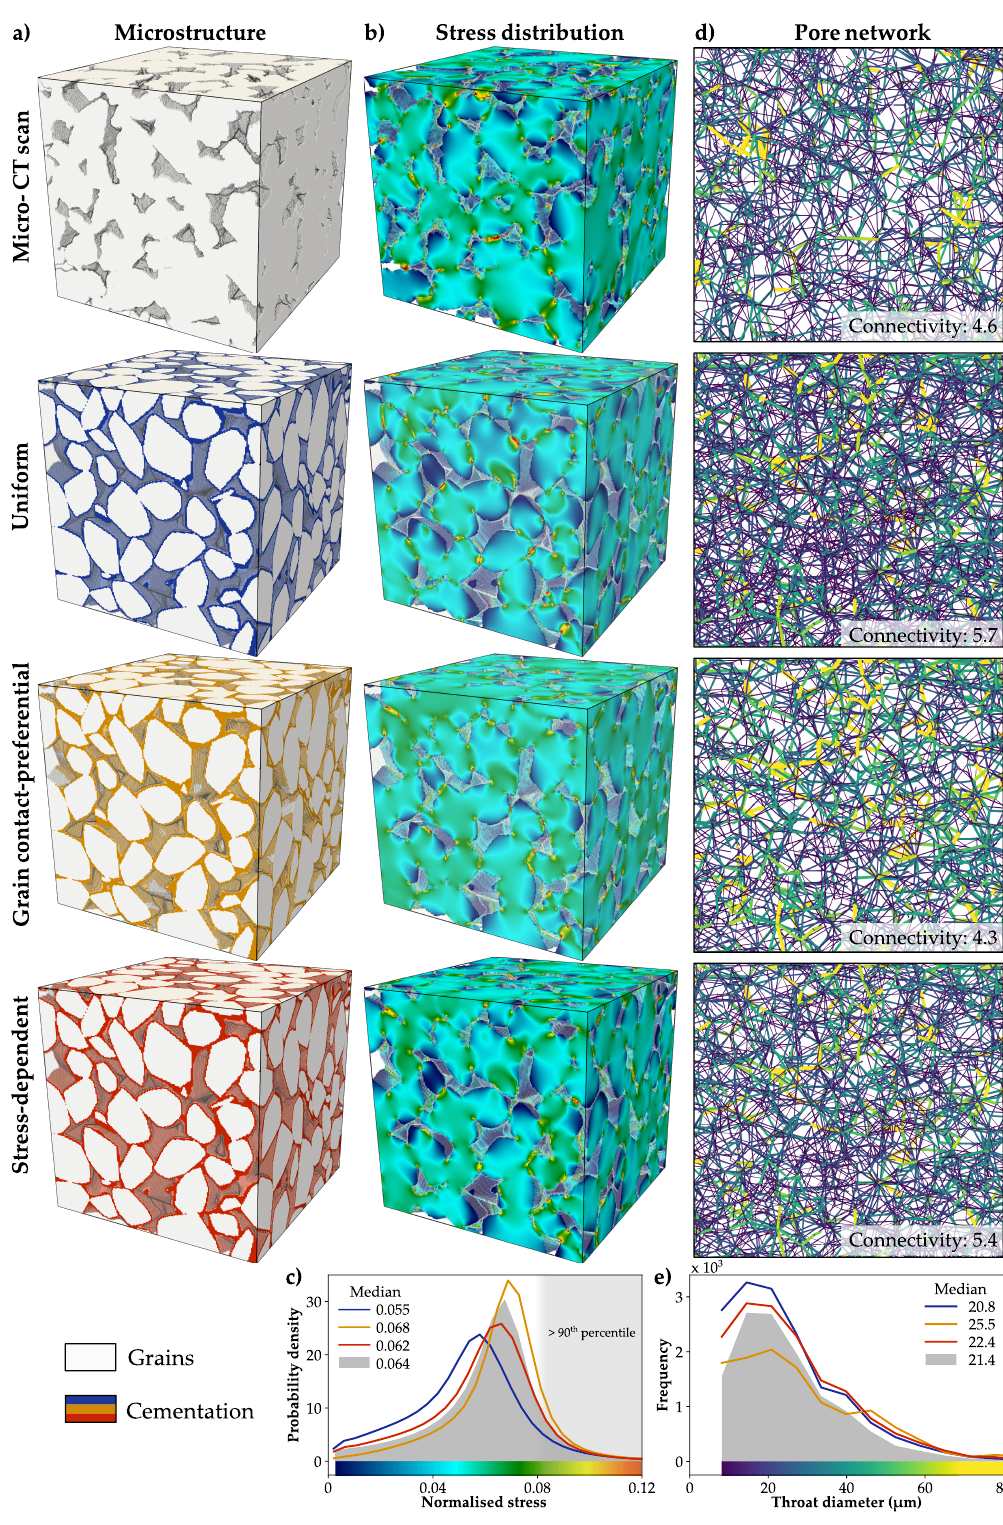
Figure 6. Microstructures and related changes in the stress distribution and pore network of the synthetic Bentheim samples compared to the respective micro-CT scan. ( a ) Cementation patterns of the uniform (blue), contact-preferential (orange) and stress-dependent scheme (red). ( b ) stress distribution. The grains of the 200 3 voxel subsets are coloured by ( c ) normalised stress. ( d ) The connectivity is illustrated by the pore network of the 400 3 voxel subsets, whereby the throats are coloured by ( e ) their respective